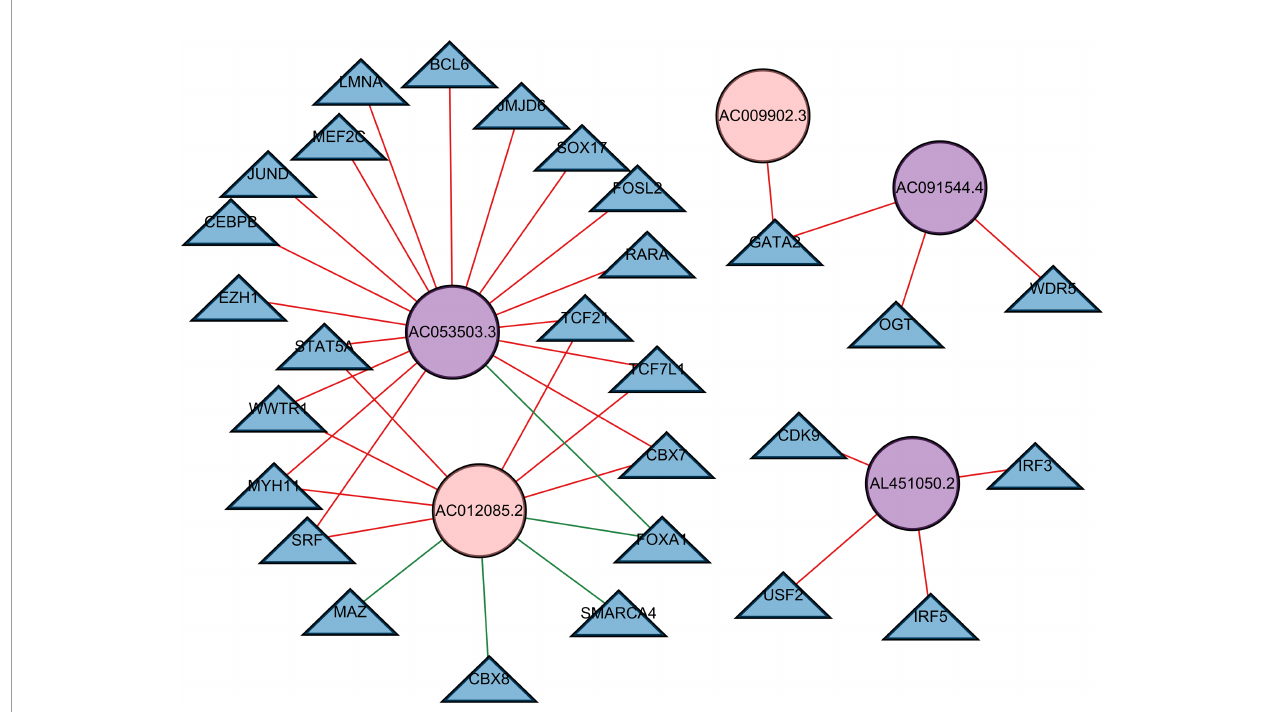
FIGURE 8 | A transcription factor – lncRNA regulatory network. The regulatory network was constructed, which consisted of fi ve lncRNAs with independent prognostic value. The blue nodes represent transcription factors, the purple nodes represent high-risk lncRNAs, and the pink nodes represent low-risk lncRNAs. Positive regulations between TFs and lncRNAs are displayed as red lines. Negative regulations are displayed as green